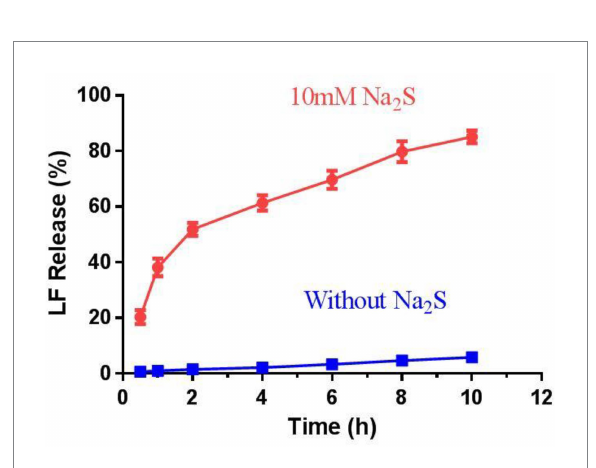
FIGURE 6 The release behavior of drugs from CS-SS-LF micelles in vitro . The release studies were conducted at pH 7.4 and 37 ° C with or without Na 2 S, respectively.